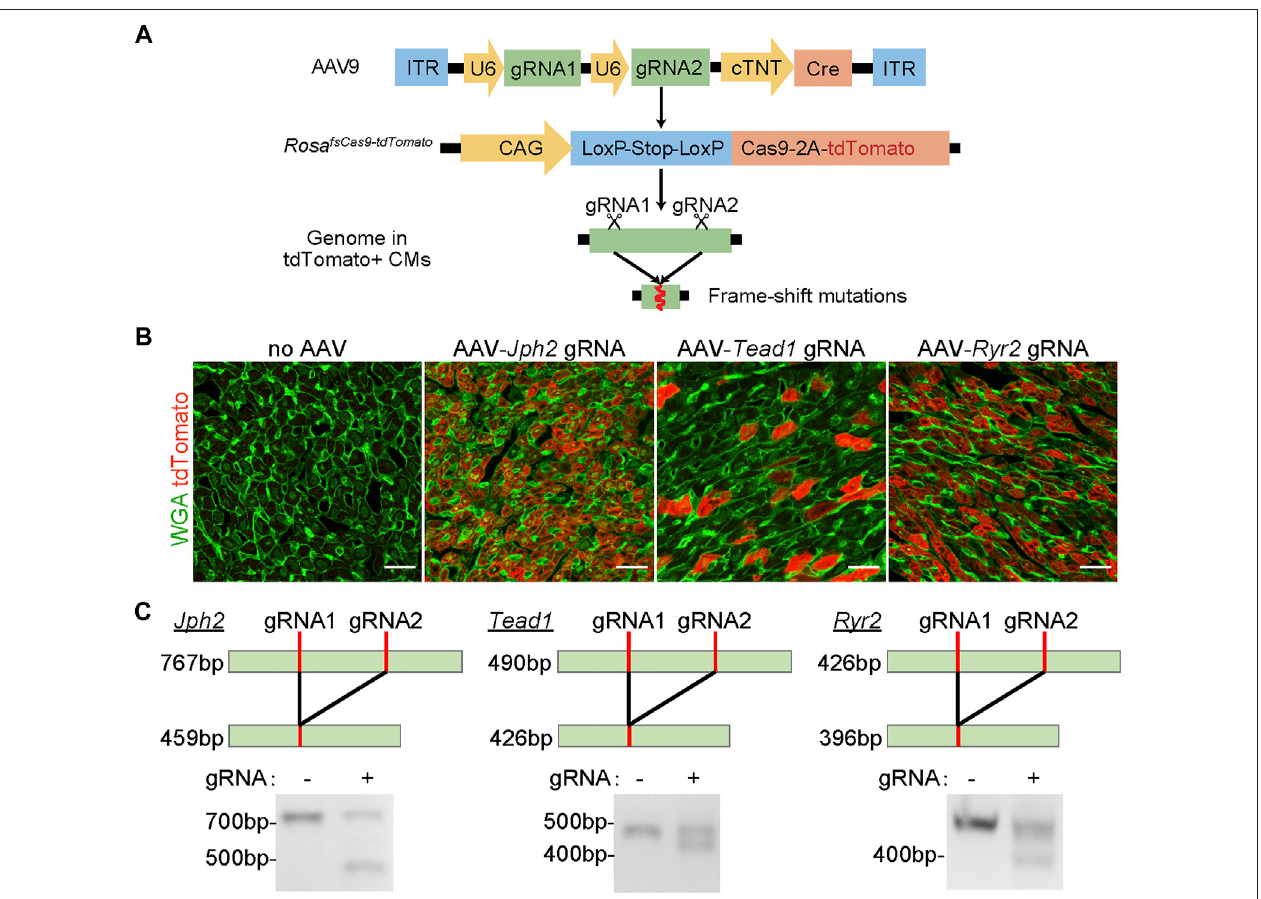
FIGURE1 | Thevalidation ofthe CASAAV system. (A) , Diagram ofthe CASAAV workingmechanism. In AAV9, U6 promoters drivethe expression ofsgRNAs. The cardiomyocyte-speci fi ccTNTpromoterdrivesCreexpression.CreactivatestheexpressionofCas9-2A-tdTomatoinRosa Cas − Tom mice.Cas9-sgRNAcomplexestarget the gene of interest by inducing frame-shiftmutations. ( B) , Confocal images ofcardiac ventricular cryo-sections. The hearts were treated with AAVs previously validated in CASAAV experiments. WGA, wheat germ agglutinin. Scale bar, 20 μ m. (C) , RT-PCR analysis of CASAAV targeted regions.